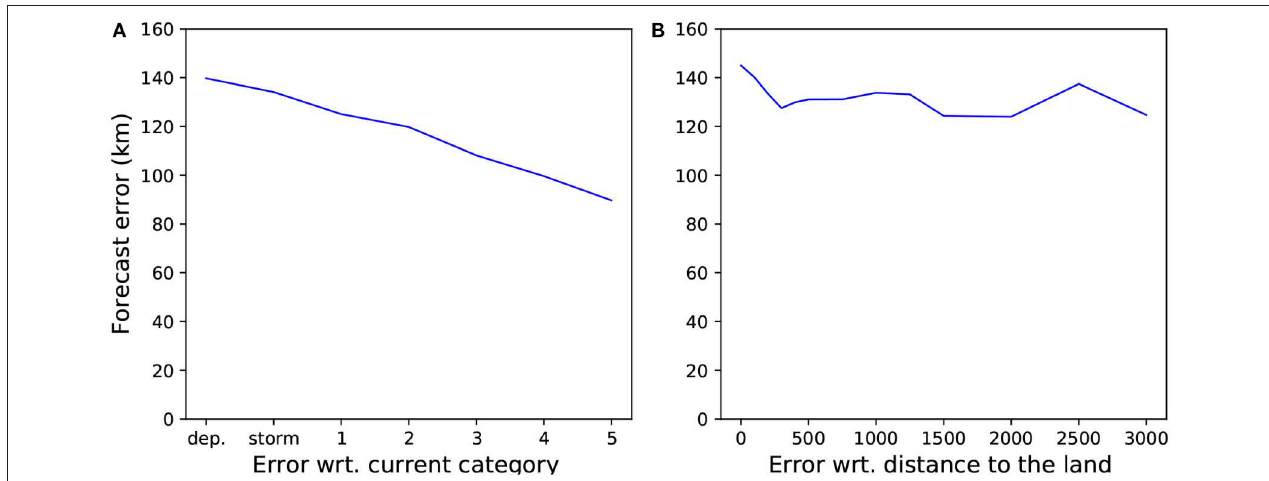
FIGURE 5 | 24 h-forecast mean errors on the whole test set with respect to (A) the current Saffir-Simpson hurricane category (a higher category means a stronger hurricane, dep means tropical depression, storm means tropical storm); (B) its current distance to land.